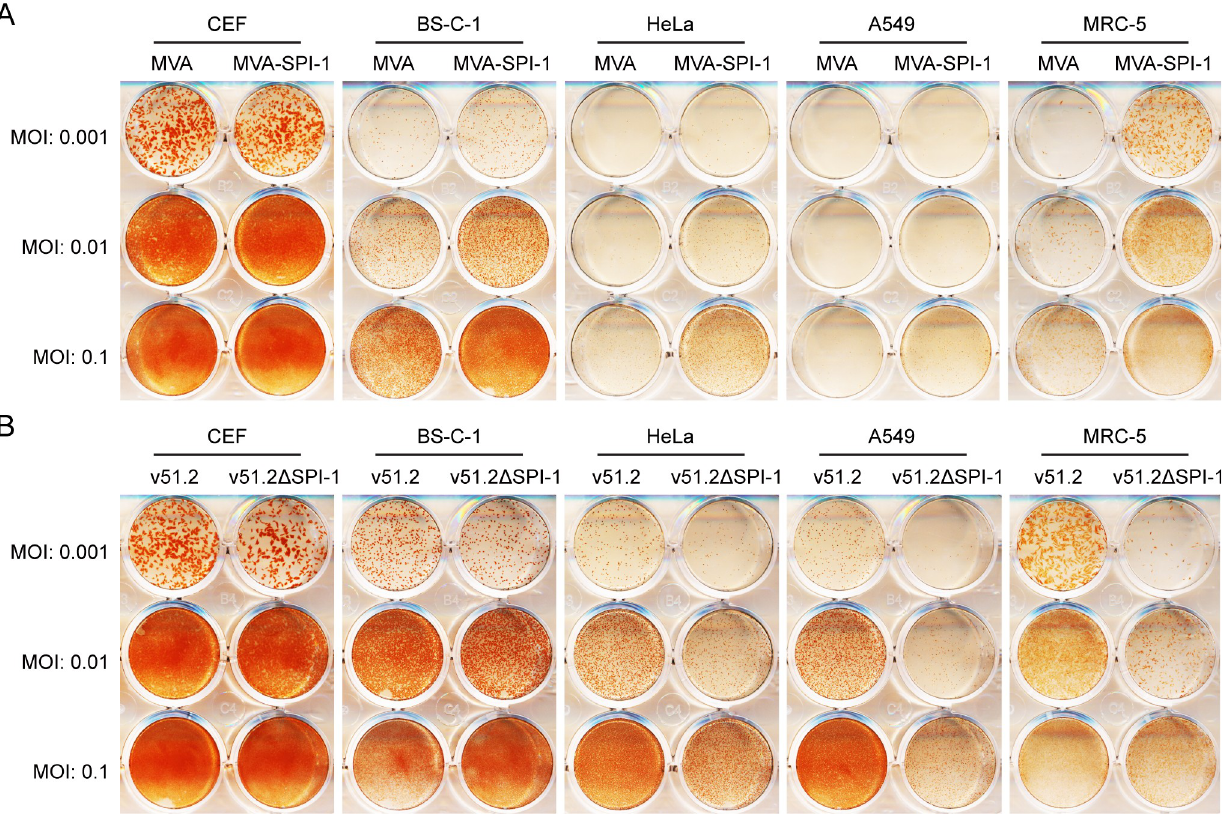
Fig 2. Requirement of SPI-1 for spread of MVA in human cells. (A) Effect of addition of the SPI-1gene to MVA. CEF, BS-C-1, HeLa, A549 and MRC-5 cells in 12-well plates were infected with MVA or MVA-SPI-1 at MOI of 0.001, 0.01 and 0.1 and overlaid with methylcellulose. After 48 h, the overlay was removed and cells were stained with antibody to VACV. (B) Effect of SPI-1 gene deletion on v51.2 spread. CEF, BS-C-1, HeLa, A549 and MRC-5 cells in 12-well plates were infected with v51.2 or v51.2 Δ SPI at MOI of 0.001, 0.01 and 0.1 and overlaid with methylcellulose. After 48 h, the overlay was removed and cells were stained with antibody to